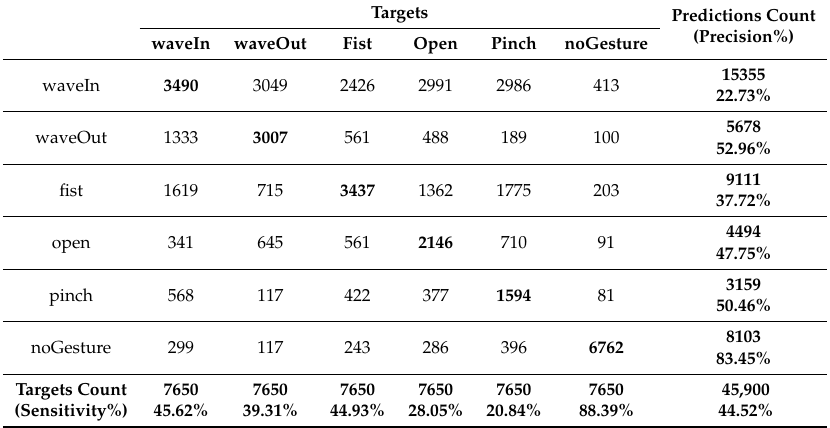
Table 8. Confusion matrix of experiment 2 for the user-general model. Rotation of the bracelet = YES (on the test set), orientation correction = NO . The sync gesture was not used. Classification accuracy =